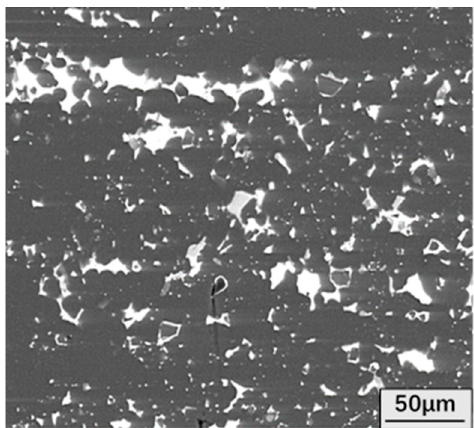
Figure 1. Microstructures of the Al-Sn alloy.